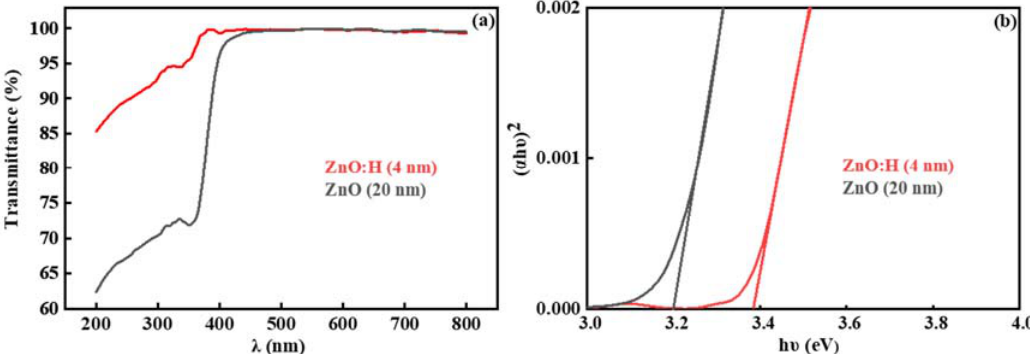
Figure 7. ( a ) UV-Vis transmission spectra and ( b ) the function relationship curves of ( α h ν ) 2 - h ν of ZnO:H prepared at H 2 /(Ar + H 2 ) = 0.13% and ZnO channel layers.